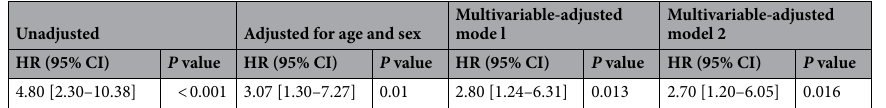
Table 4. Association between higher sCys C level and severe COVID-19 illness in a sensitivity analysis. Abbreviations: sCys C = serum cystatin C; COVID-19 = coronavirus disease 2019; HR = Hazards ratio; Multivariable Model 1: Adjusted for age, sex, increased lactate dehydrogenase, decreased lymphocyte, and qSOFA (Quick Sequential Organ Failure Assessment). Multivariable Model 2: Adjusted for age, sex, increased lactate dehydrogenase, decreased lymphocyte, and vascular risk factor